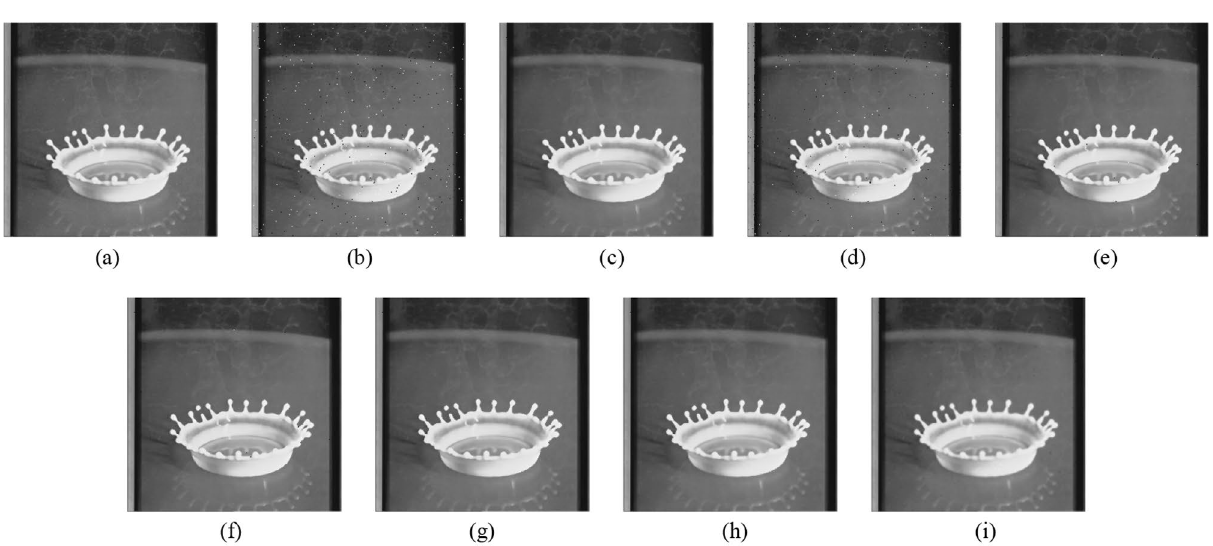
Figure 13. Comparison of denoising performance of each filter against the salt-and-pepper noise (“Milkdrop”). ( a ) Original image; ( b ) noise-added image; ( c ) filtered image using abwFMGFI; ( d ) filtered image using FMGFI (BW = 1 level); ( e ) filtered image using FMGFI (BW = 3 level); ( f ) filtered image using FMGFI (BW = 5 level); ( g ) filtered image using FMGFI (BW = 11 level); ( h ) filtered image using FMGFI (BW = 21 level); ( i ) filtered image using FMGFI (BW = 51